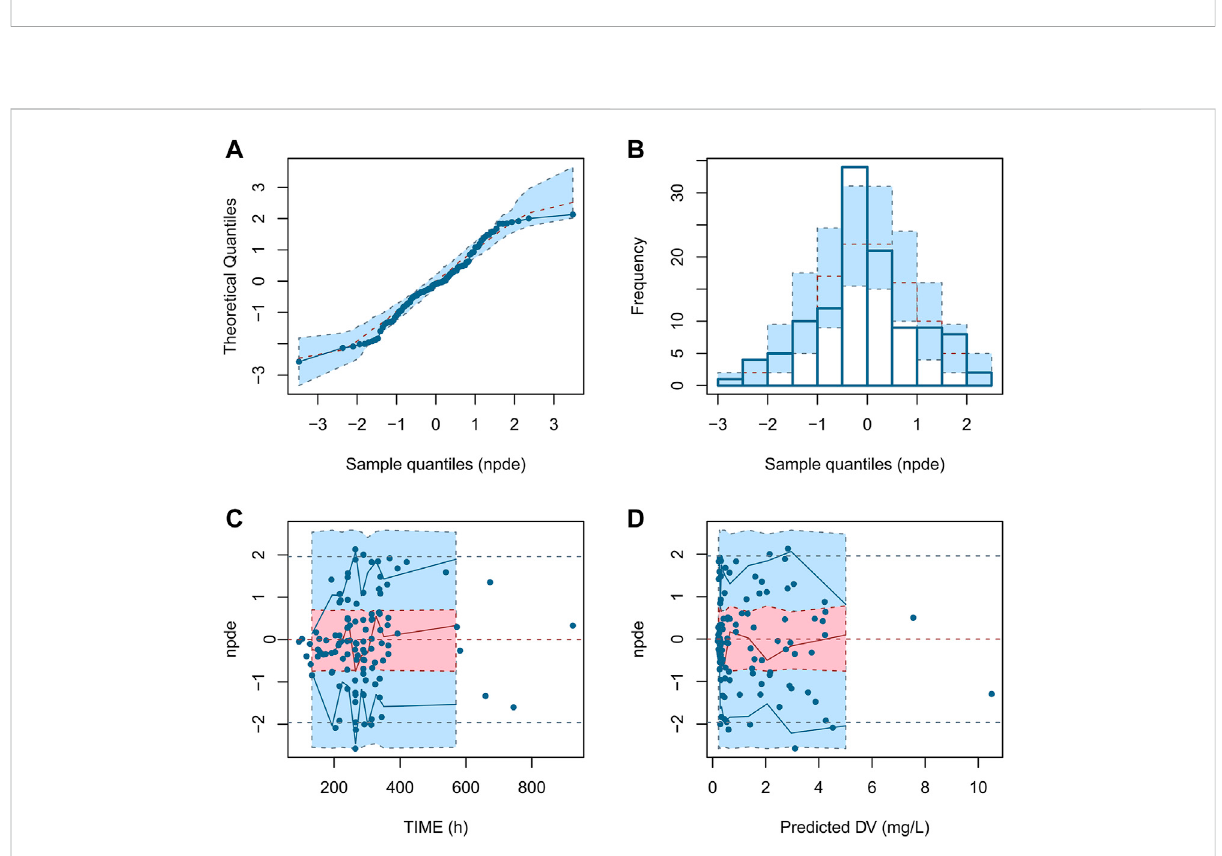
FIGURE 5 NPDE diagnostic diagram of the fi nal model. (A) Q - Q plot of NPDE vs. normalized distribution; (B) Distribution diagram of predictive distribution error; (C) NPDE vs. TIME; (D) NPDE vs. PRED.